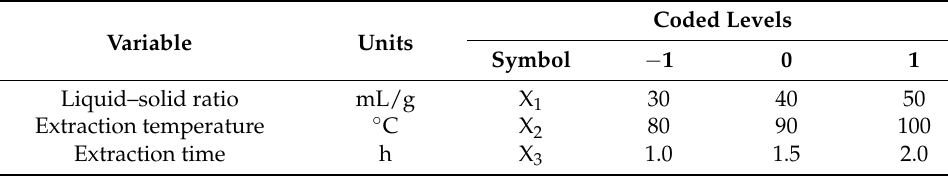
Table 5. Factors and levels for the Box–Behnken response surface method. Variable Units